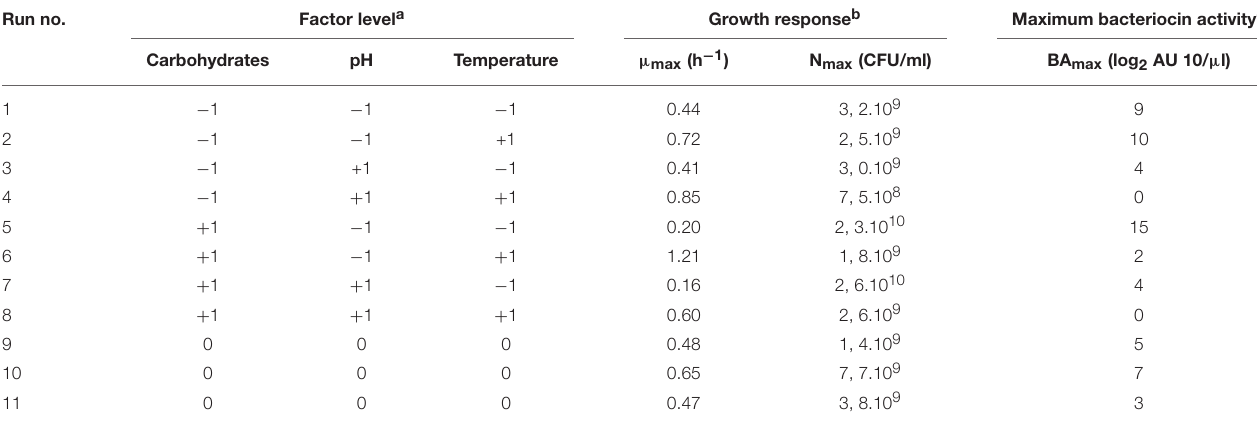
TABLE 2 | Experimental design and factor levels (coded values) used to model maximum growth rate ( µ max ), maximum bacterial count (N max ), and bacteriocin activity (BA max ) of C. divergens V41 as a function of carbohydrates concentration, pH and temperature. Run